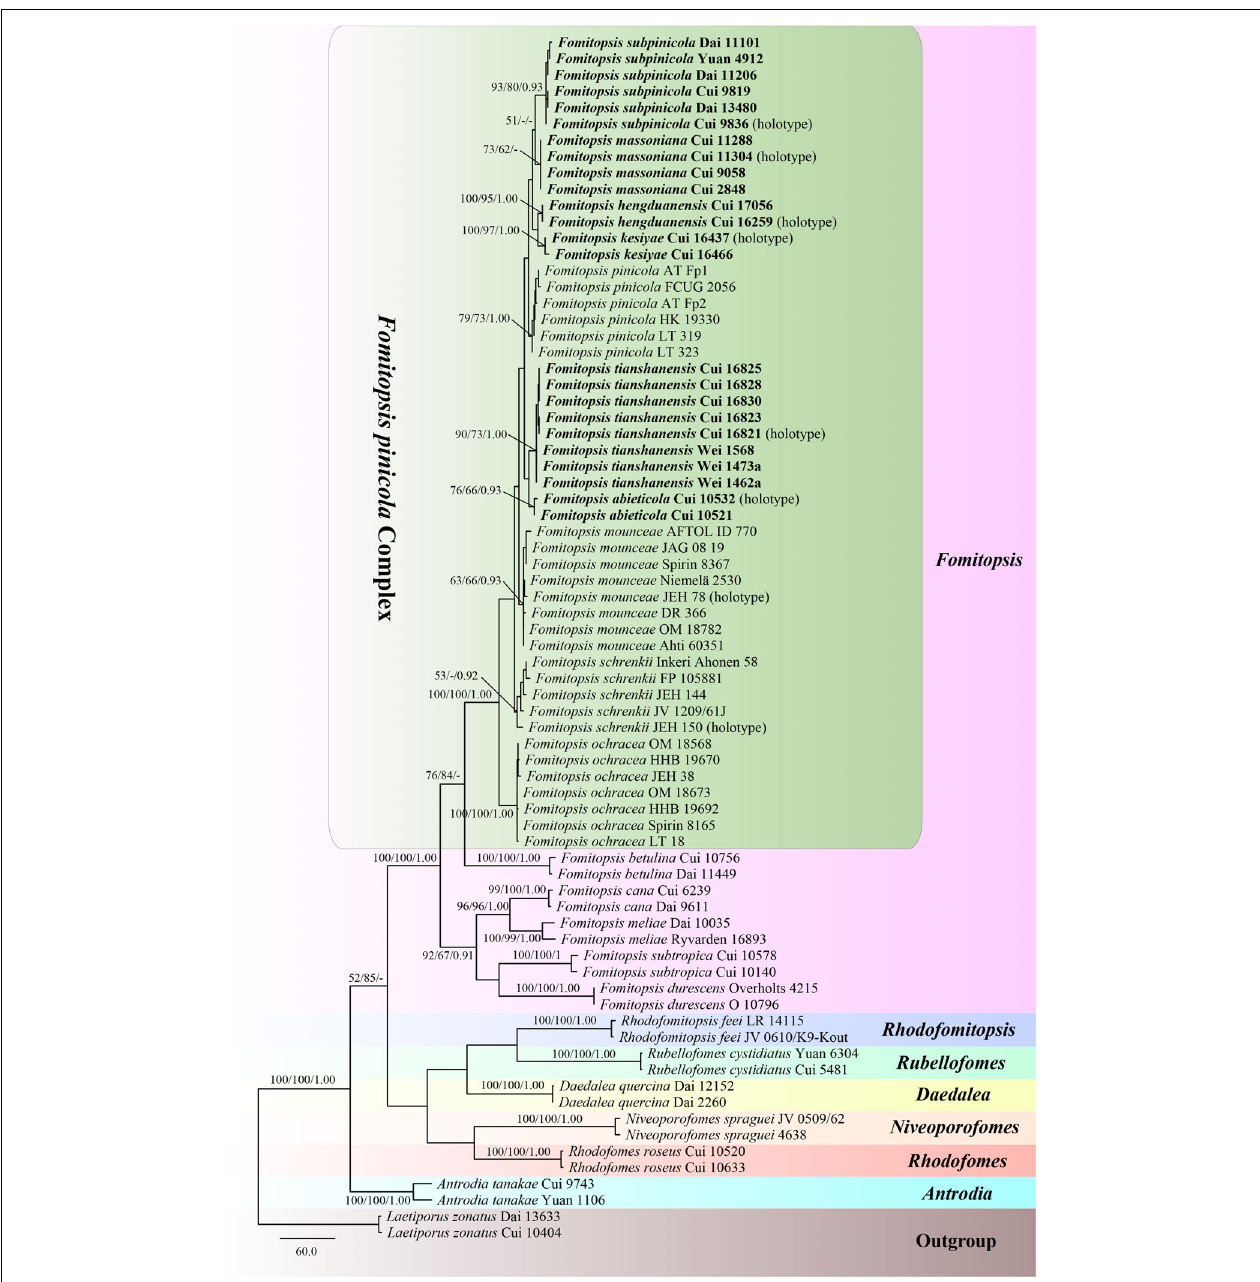
FIGURE 2 | Maximum parsimony tree illustrating the phylogeny of the Fomitopsis pinicola complex and related group based on the combined sequences dataset of ITS + RPB2 + TEF. Laetiporus zonatus served as the outgroup. Branches are labeled with maximum likelihood bootstrap higher than 50%, maximum parsimony bootstrap proportions higher than 50% and Bayesian posterior probabilities more than 0.95. Bold names = New species.